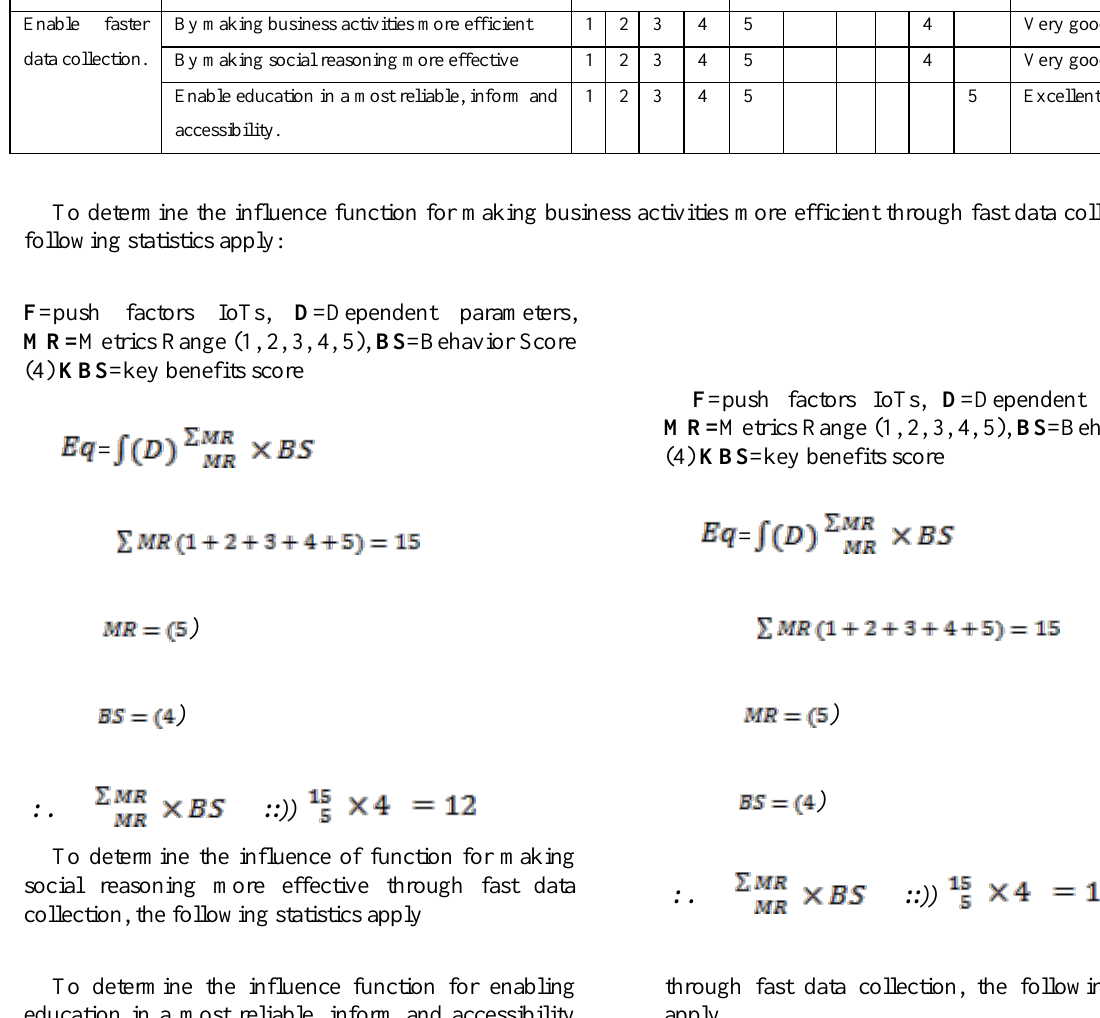
Table 3. determination of Behavior score Influence of IoTs base on faster data collection. Source: owner Push Factors IoTs Enable faster data